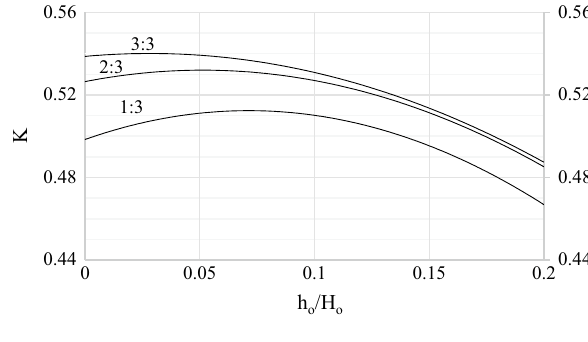
Fig. 10 Value of K in Eq.